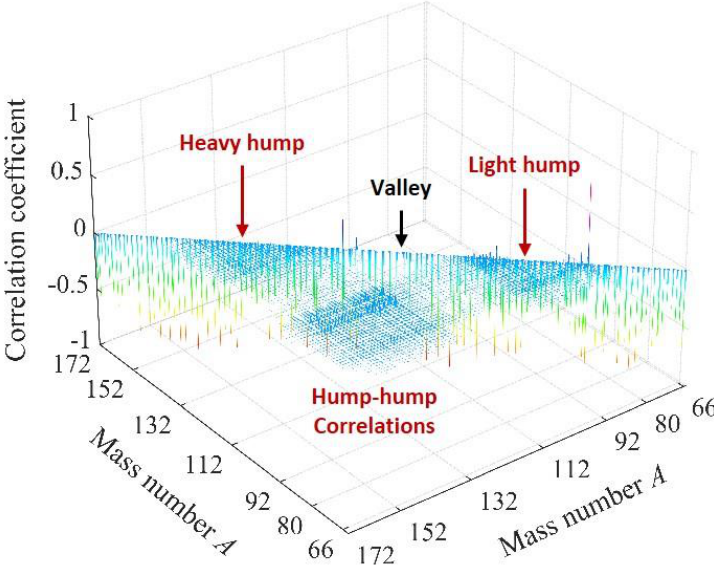
Figure 2. Estimated independent yield correlation matrix. Upper diagonal is omitted in the figure. The axis is the mass number of these fission products. These fission products are ordered firstly by decreasing mass number, and then increasing charge number within each mass